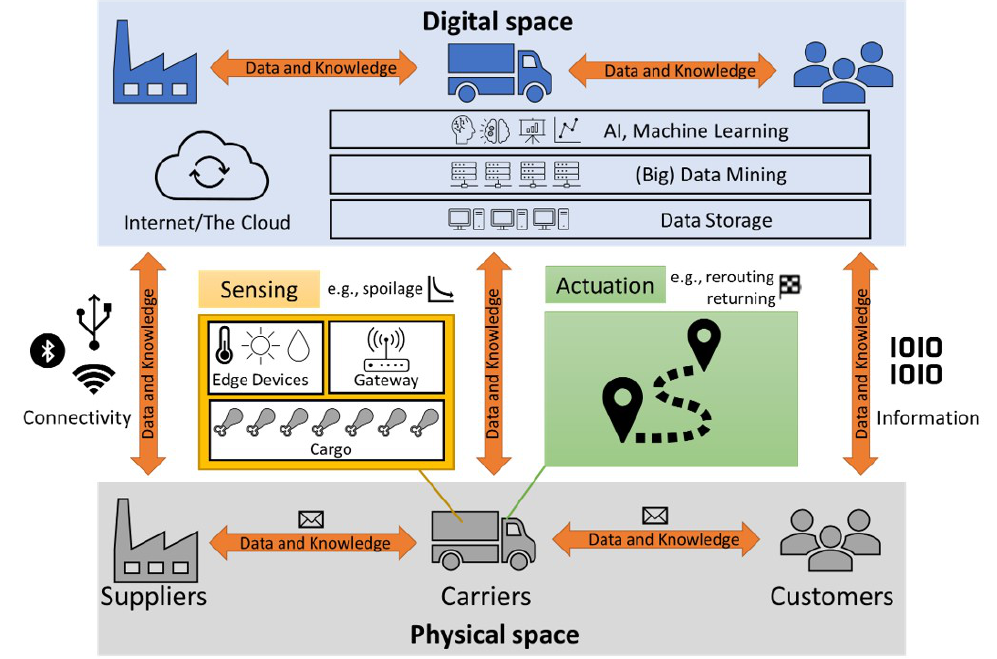
Figure 2. The conceptual model of a general digitalised distribution cold